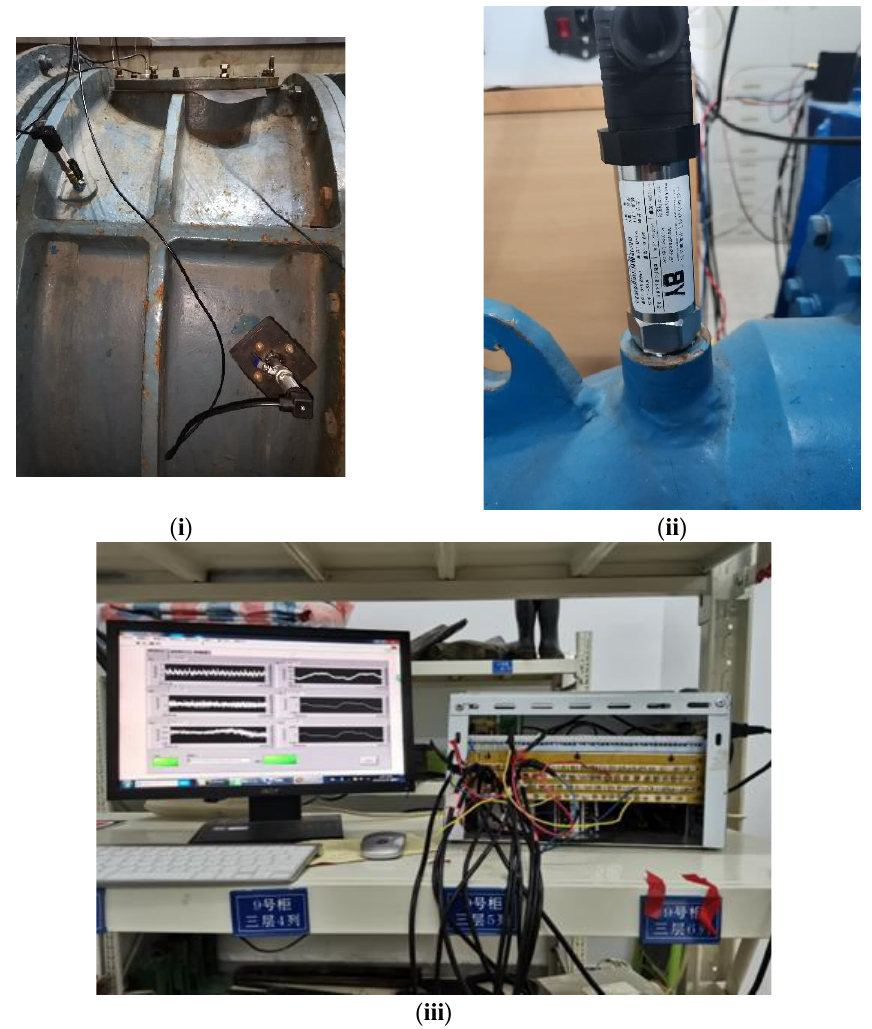
Figure 7. Experimental setup. ( ⅰ ) Monitoring point layout. ( ⅱ ) Pressure sensor. ( ⅲ ) Measuring instrument.